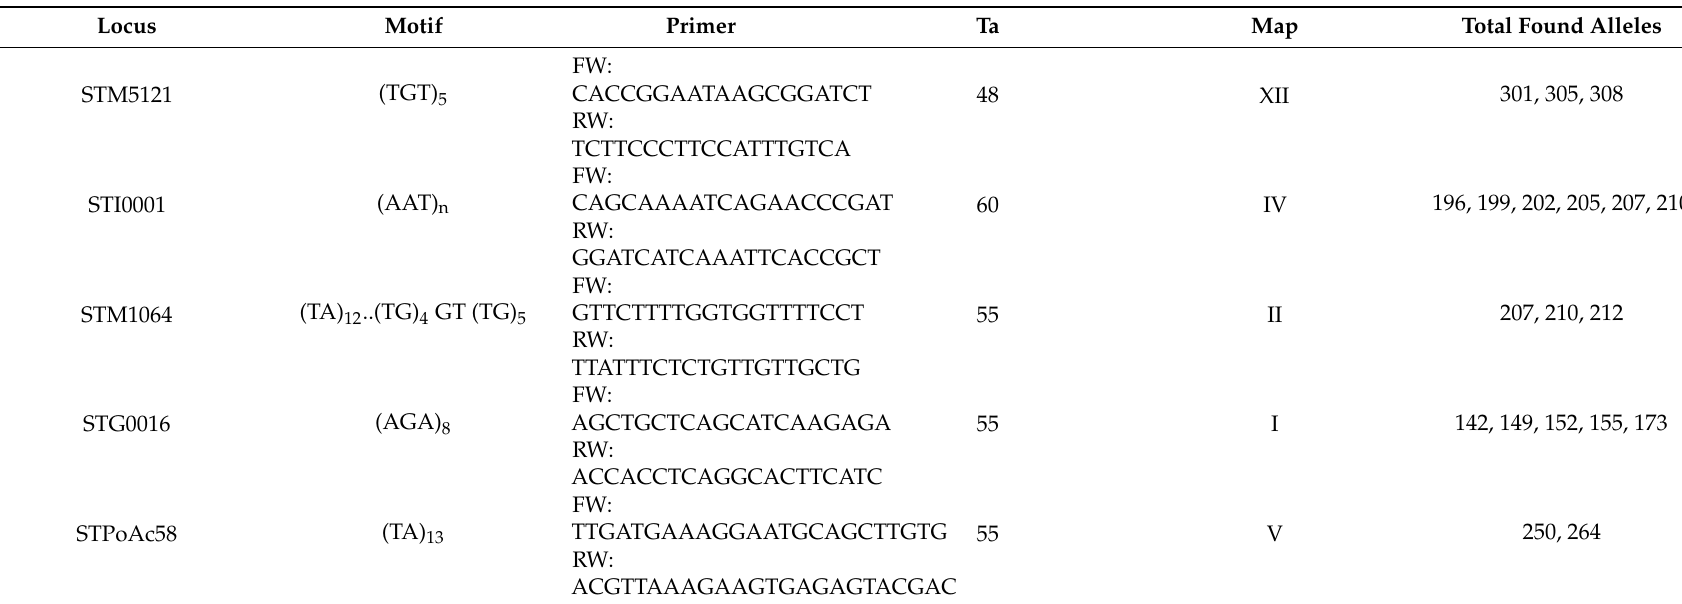
Table A2. List of microsatellite loci used for genotyping the eight potato accessions. For each locus, the repeated pattern, the primer sequences, the annealing temperature (Ta), the chromosome position, and alleles found are reported. Locus Motif Primer Ta Map Total Found Alleles